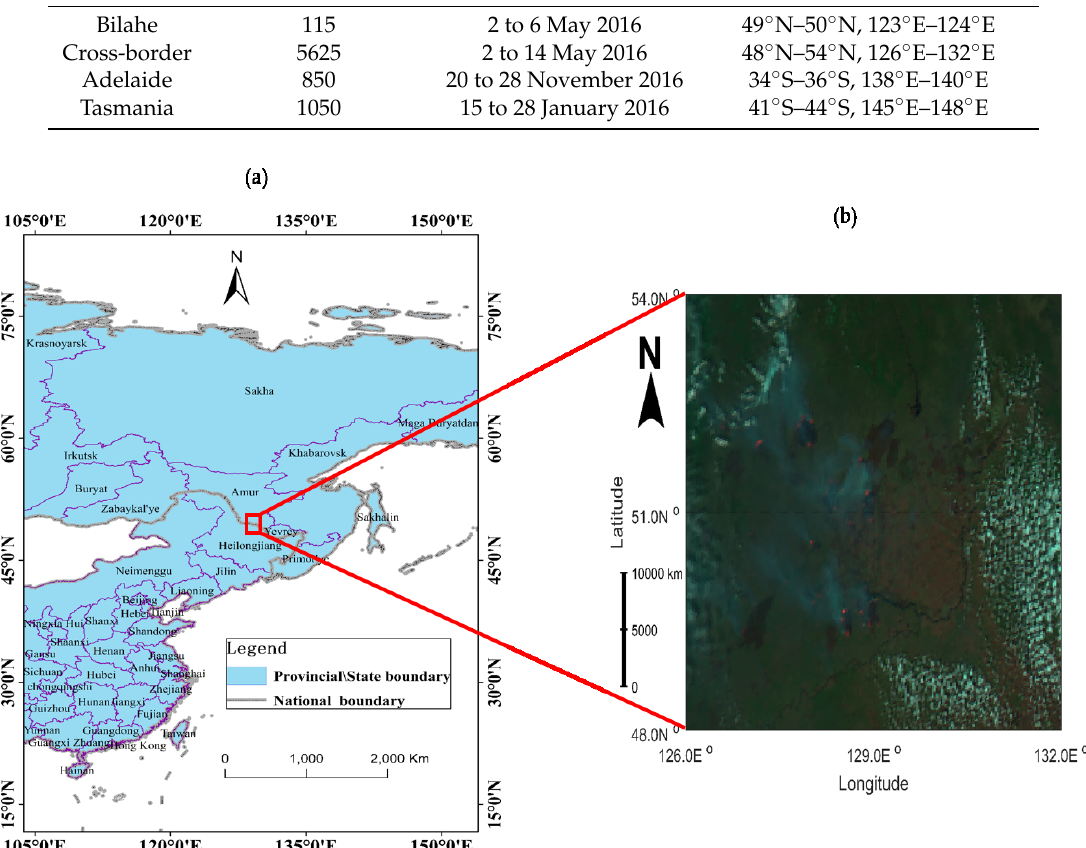
Figure 1. The location of the study area ( a ); and the 2-km H-8 false color image (6 4 3 band combination) acquired at 04:20 of 3 May 2016 (UTC) ( b